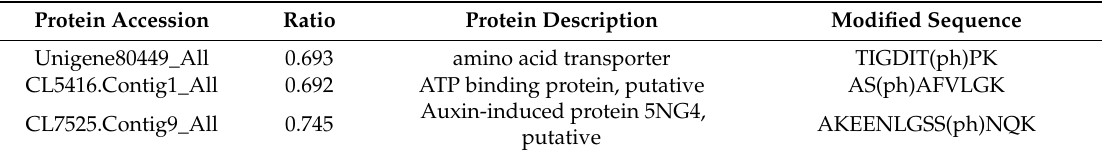
Table 1. Membrane and transport-related proteins differentially expressed under salt stress in okra leaves .